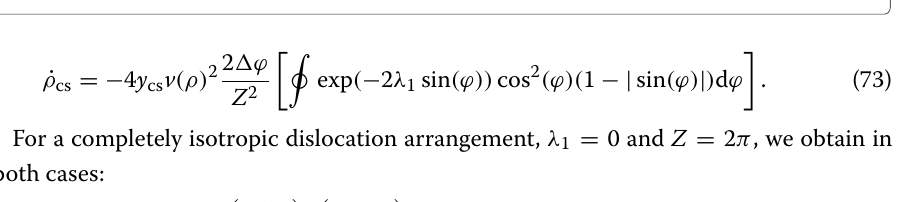
Fig. 11 Normalized annihilation rate as a function of the GND fraction M ( 1 ) for a dislocation annihilation triggered by cross slip. Blue line: normalized annihilation rate for a DODF symmetric around screw orientation ( ϕ ρ = 0, π ). Red line: normalized annihilation rate for a DODF symmetric around edge orientation (cid:15) (cid:16) ϕ ρ = π , 3 π . Dashed lines: Parabolic annihilation rate expected from the kinetic theory 2 2